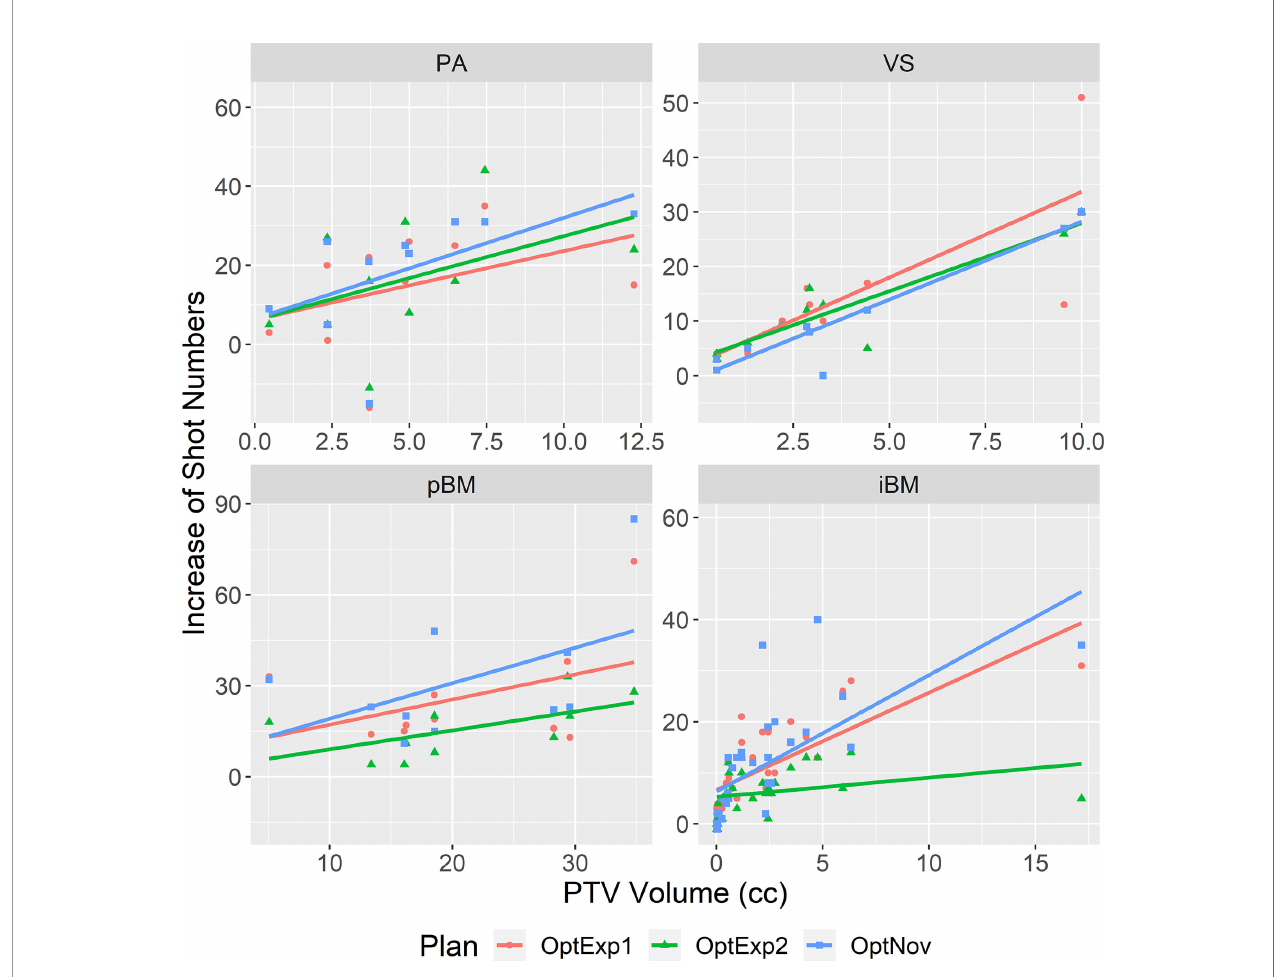
FIGURE 4 | Correlations between the increase of number of shots in the inversely optimized plans and the PTV volume. The linear regression for each site was shown in the straight line. PA, pituitary adenoma; VS, vestibular schwannoma; pBM, post-operative brain metastases; iBM, intact brain